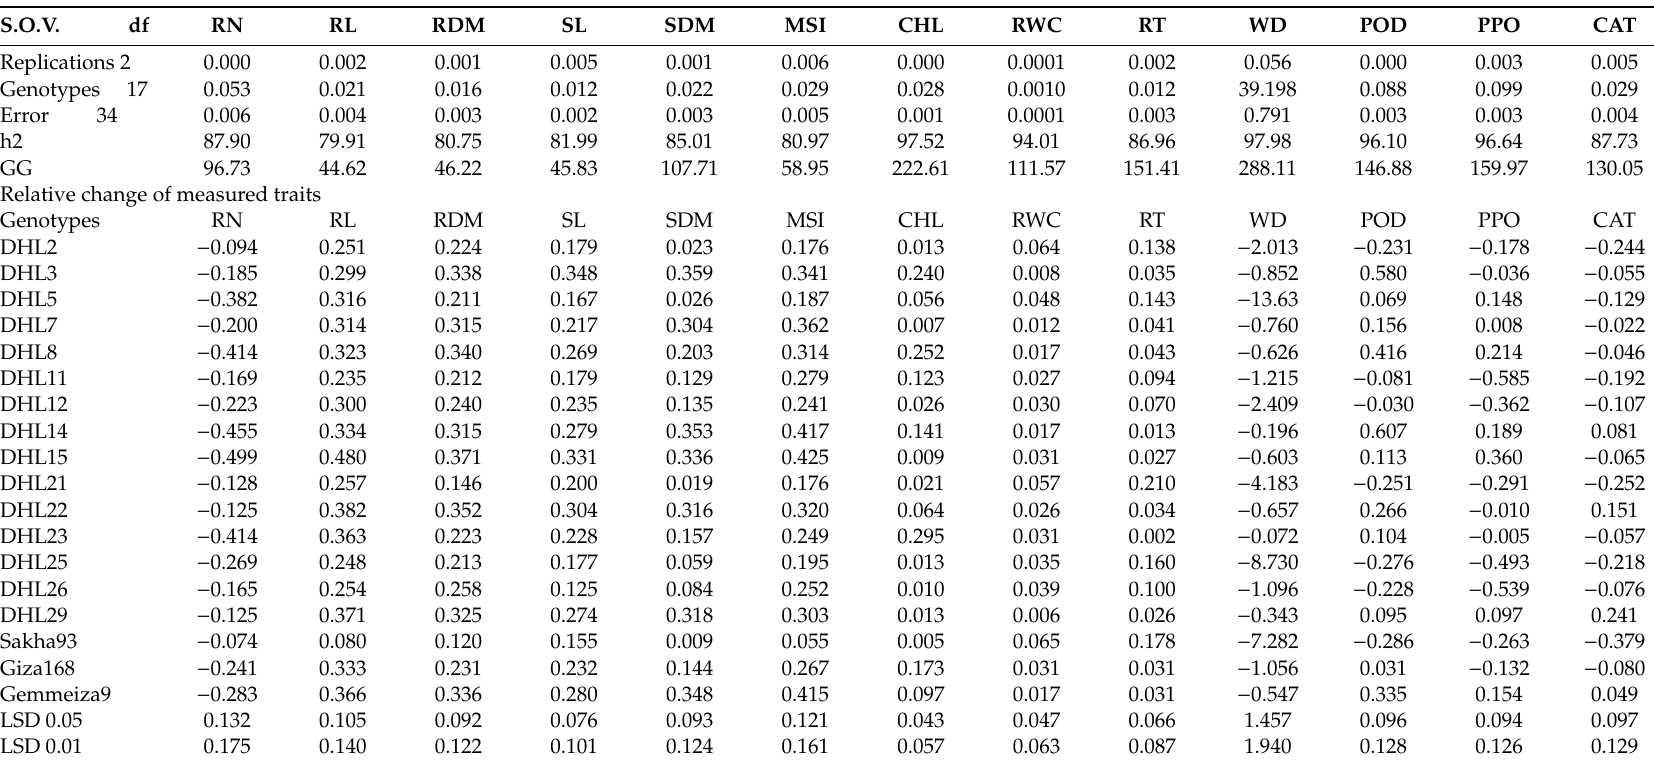
Table 2. Analysis of variance for relative change of measured traits, heritability, genetic gain, genotypic and phenotypic coe ffi cients of variability, and relative change values for traits of 18 wheat